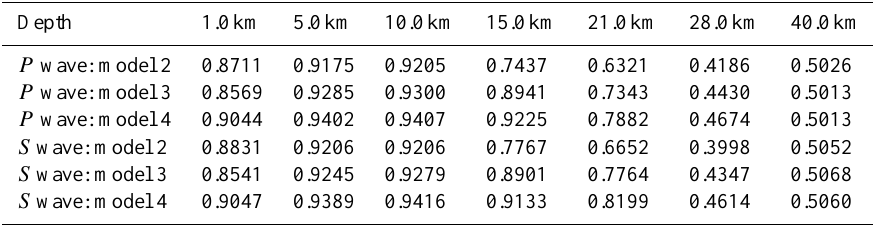
Table 2. Structural similarity indices (SSIM) ζ between the checkerboard models and the iteratively updated inversion results ( m 2 to m 4 , Figs. 8 and 9) at seven different depths for P wave and S wave checkerboard resolution tests.